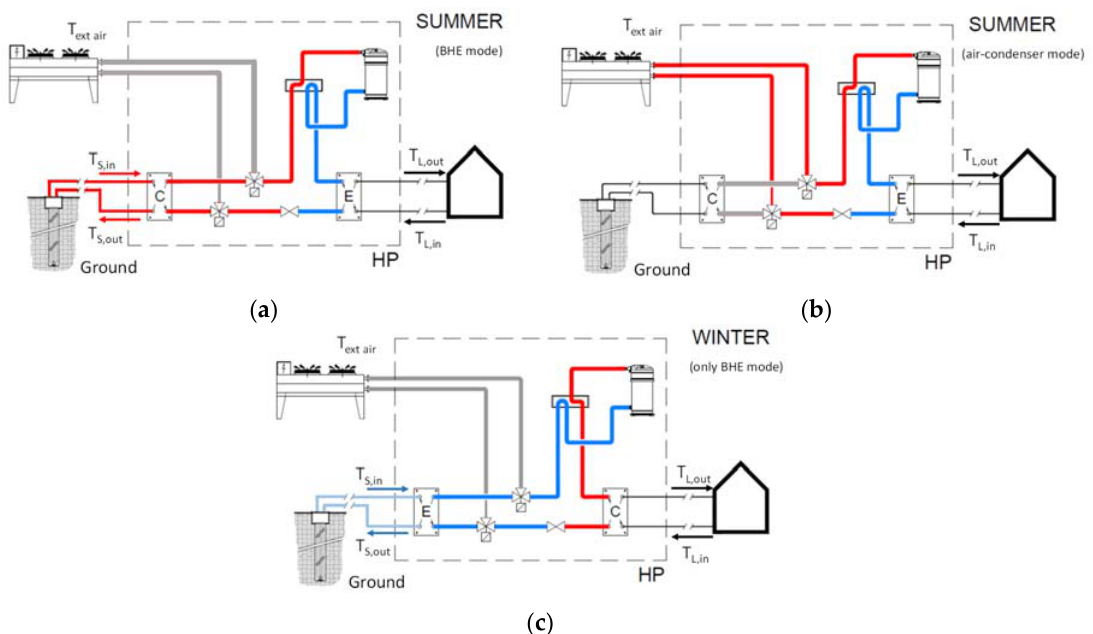
Figure 3. Measured hourly fluid temperature: ( a ) outlet fluid temperature from borehole heat exchangers with annual minimum and maximum external air temperatures, ( b ) inlet and outlet fluid temperature to/from borehole heat exchangers from May to September 2013.